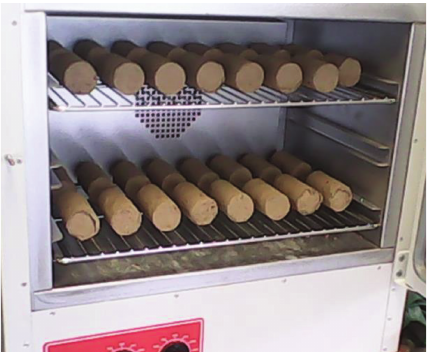
Figure 3: Drying specimen in